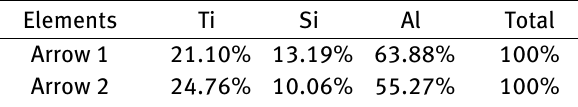
Table 2: EDS results of arrow one and two in Figure 4a